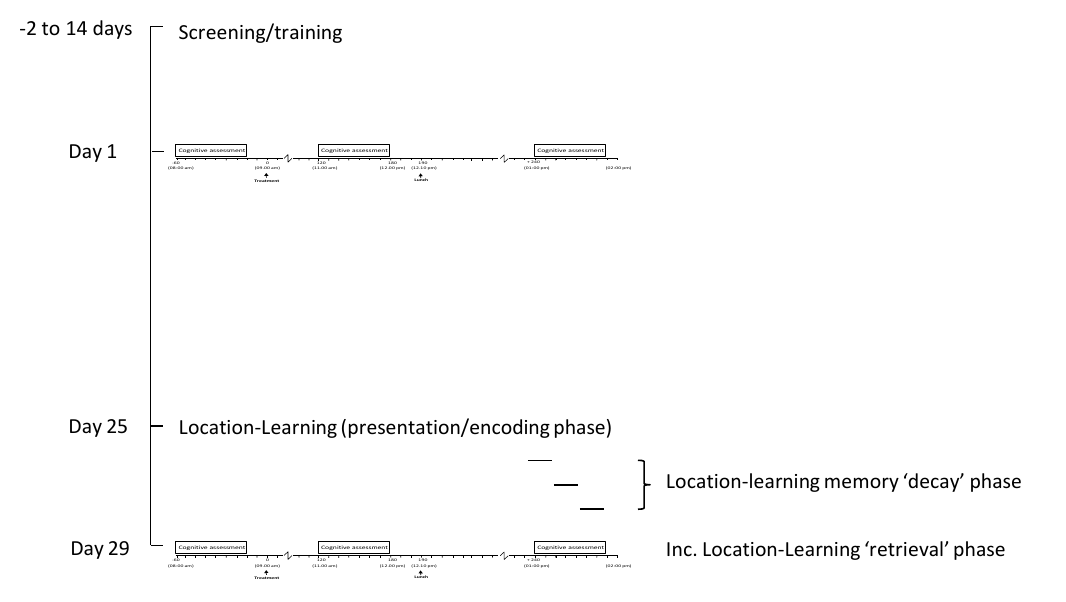
Figure 4. Overall trial diagram. The diagram includes screening/training and the main acute (day 1) and chronic (day 29) lab visit sessions. Participants returned to the lab on day 25 to first complete the location-learning task. The 3 intervening days between this and day 29 when they again completed the location-learning task acted as a “decay” phase for these encoded